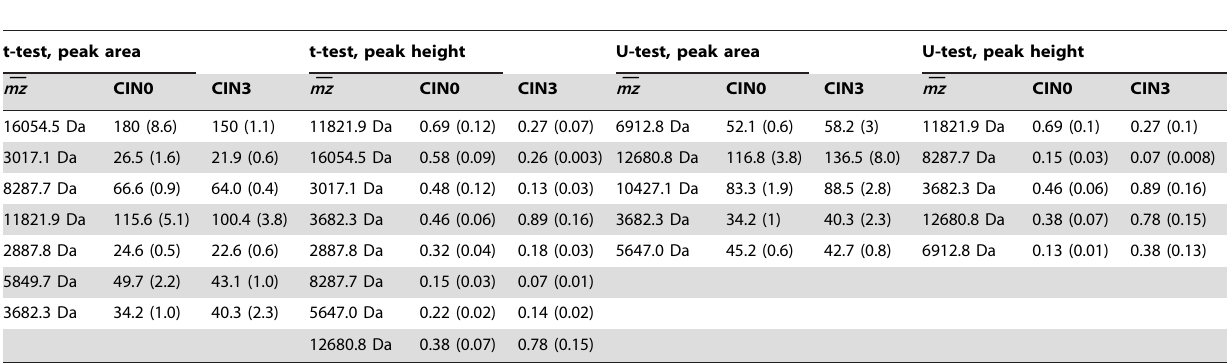
Table 2. CIN0 vs. CIN3 group tests (t-tests and Mann-Whitney U-tests) based on peak height and peak area measurements.